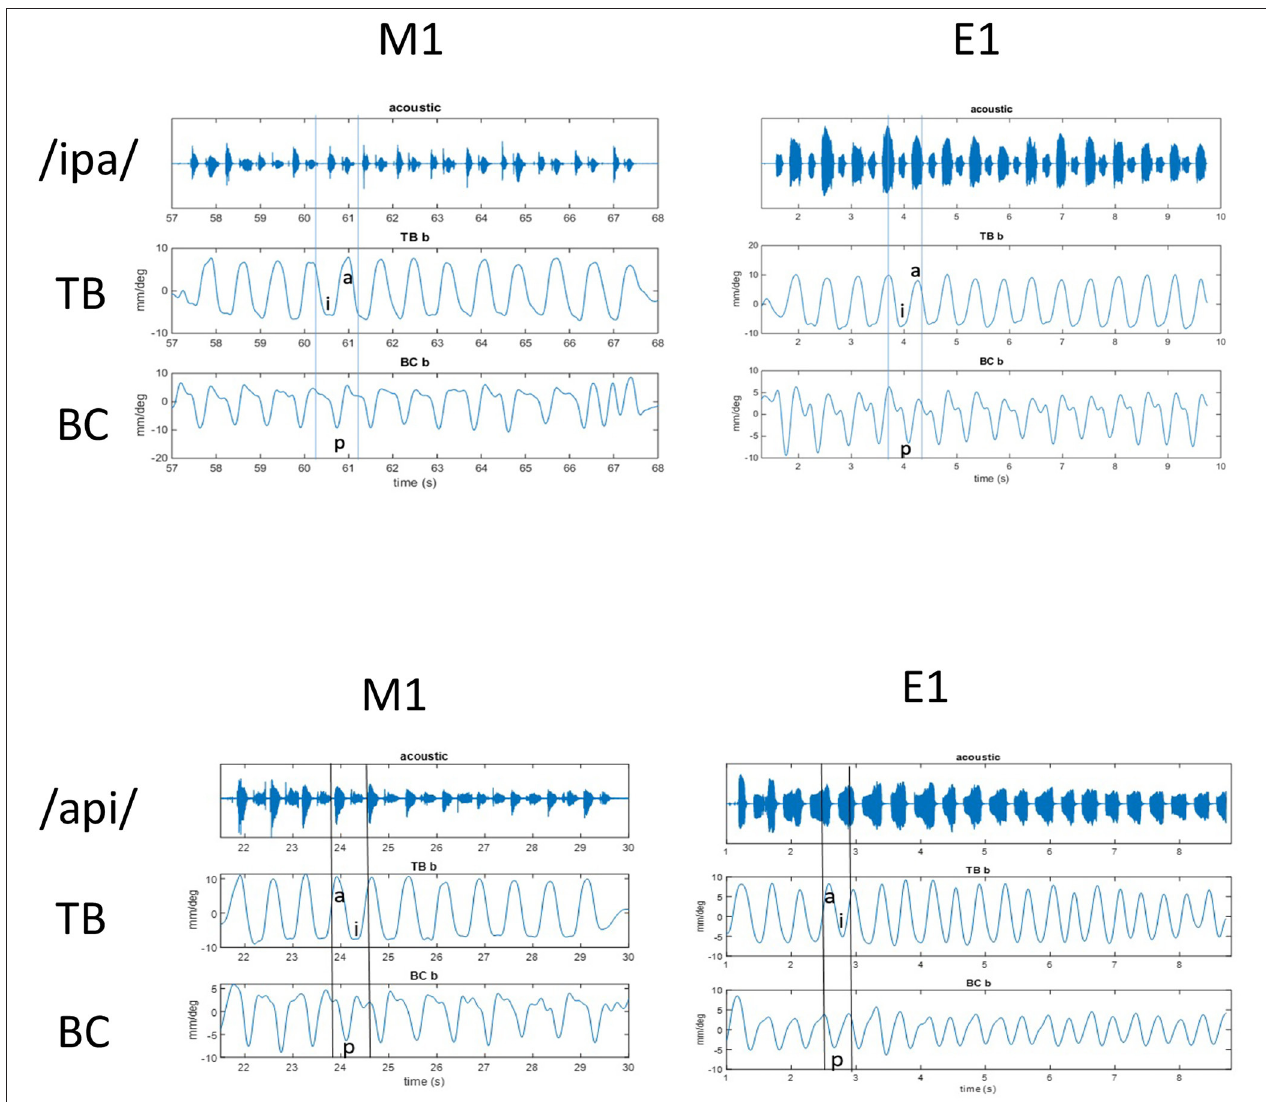
FIGURE 1 | Top: Acoustic and kinematic data for repeated [ipa] stimuli at normal rate in MASK (left) and EMA (right). Shown are (from top to bottom) waveform with audio signal, tongue body gesture (TB), and bilabial constriction (BC). Vowel positions are indicated for the 5th reiteration in TB signal and lip closure is indicated for BC signal at same time interval. Bottom: Acoustic and kinematic data for repeated [api] stimuli at normal rate in MASK (left) and EMA (right). Shown are (from top to bottom) acoustic signal, tongue body gesture (TB), and bilabial constriction (BC). Vowel positions are indicated for the 4th reiteration in TB signal and lip closure is indicated for BC signal at same time